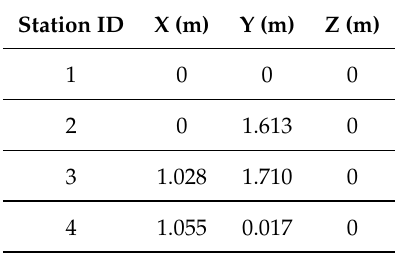
Table 6. Coordinates of the UWB